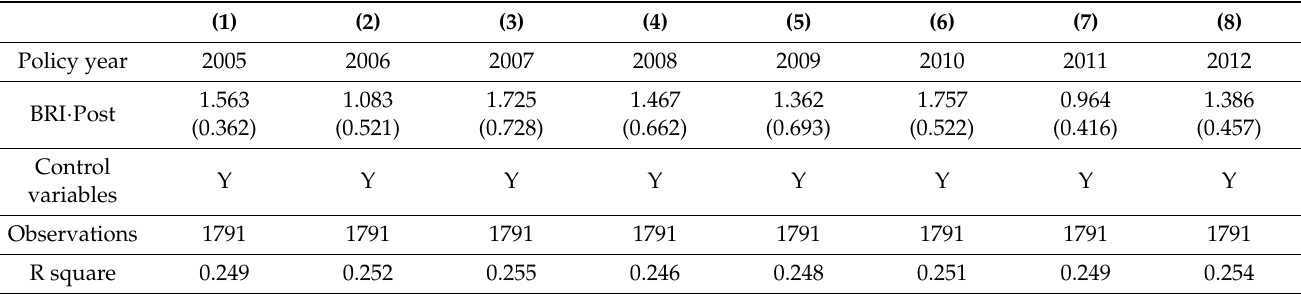
Table 3. Placebo robustness test.